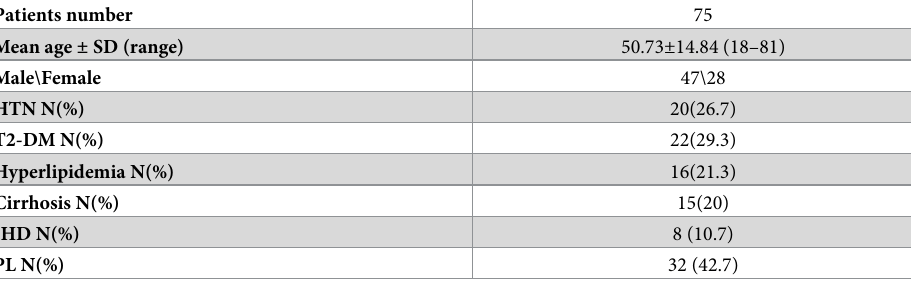
Table 1. Clinical and demographic characteristics of study participants.